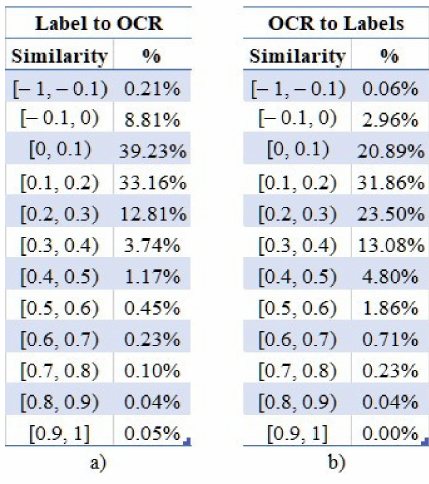
Figure 12. The distribution of cosine similarity values ( a , b ) per type of